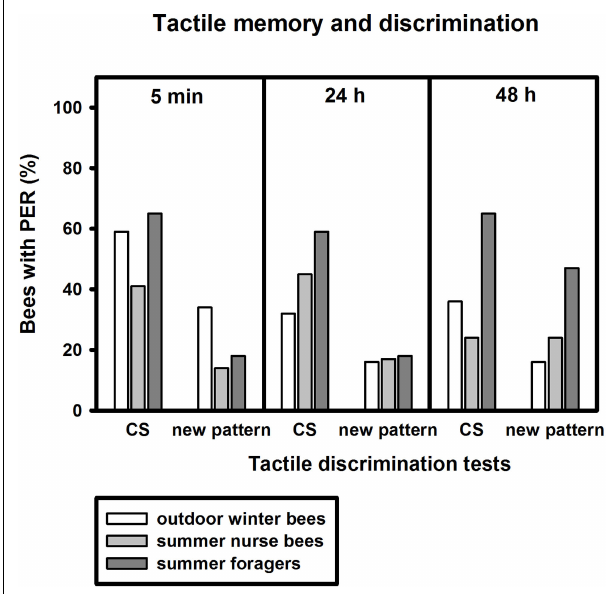
FIGURE 4 | Tactile memory and discrimination of outdoor winter bees, summer nurse bees and summer foragers. The x -axis displays the tested stimuli (conditioned vertical pattern (CS) or new horizontal pattern) at 5 min, 24 h or 48 h after conditioning. The y -axis shows the percentage of bees displaying the proboscis extension response (PER). For statistics see text. The same individuals as in Figure 2 are displayed minus individuals that did not survive the 48-h